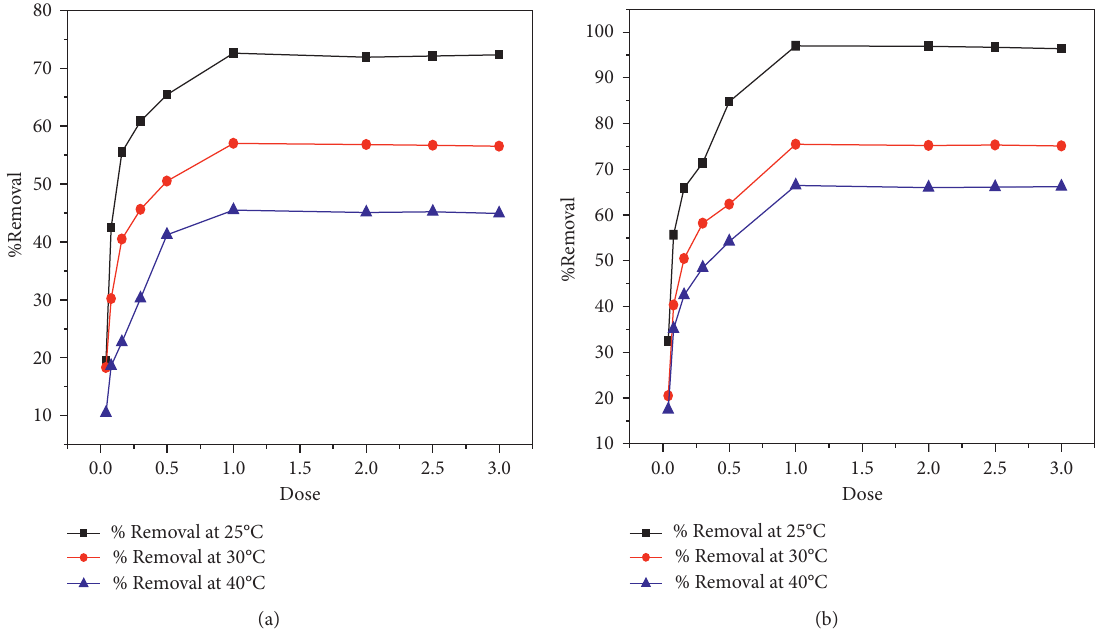
Figure 5: (a, b) The effect of adsorbent dosage at different temperatures (25, 30, and 40 ° C) for Pb(II) ions removal using CNM and NaIO CNM adsorbents, respectively, at optimum contact time of 120min, solution pH of 6, 30mg/L initial concentration of Pb(II) ions, and agitation speed of 250rpm.